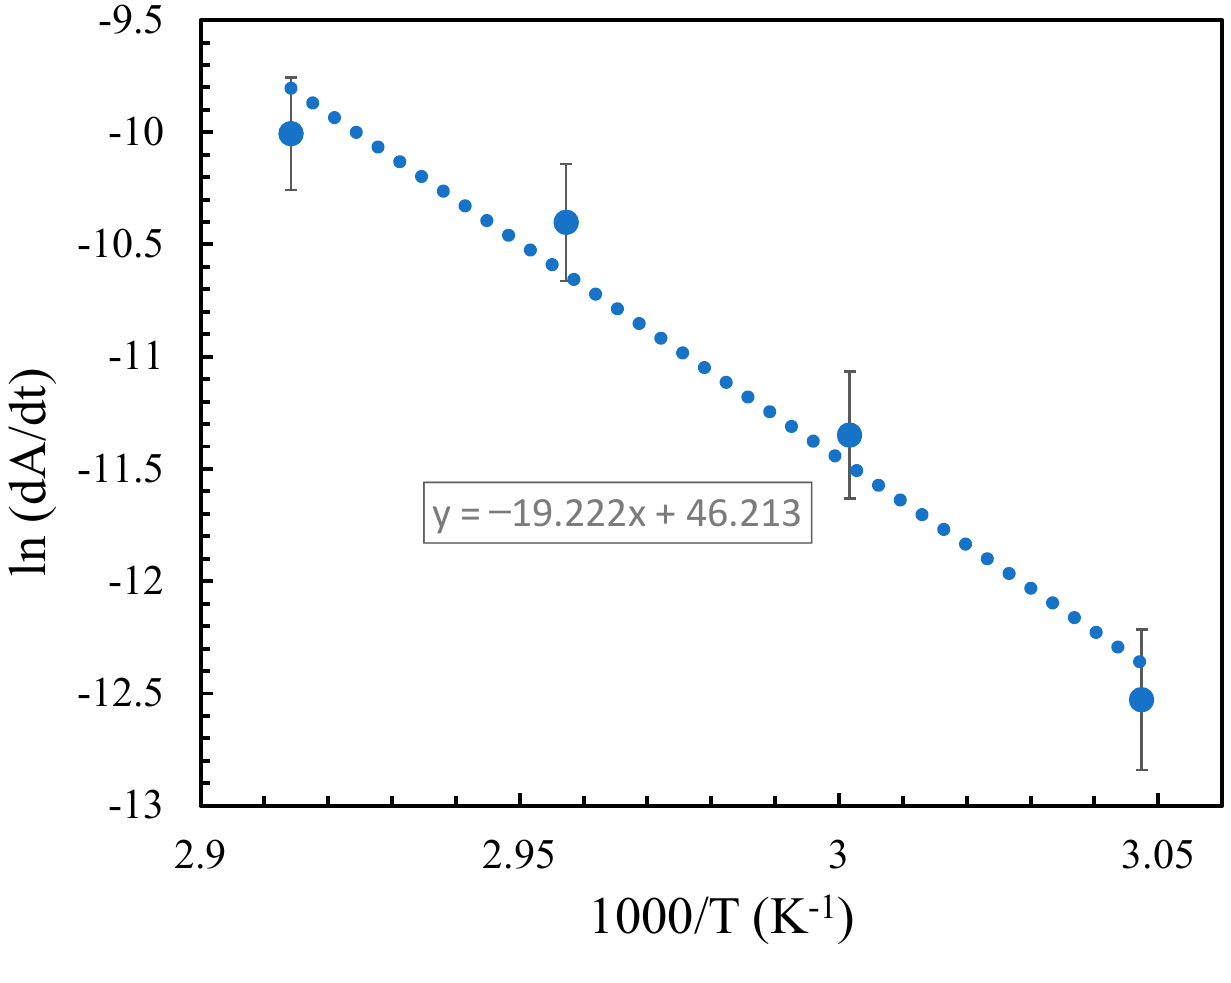
Figure 4. A plot of the logarithm of the shrinkage rates of TNT surface island vs the inverse of the absolute temperature, slope determines the activation energy of sublimation.